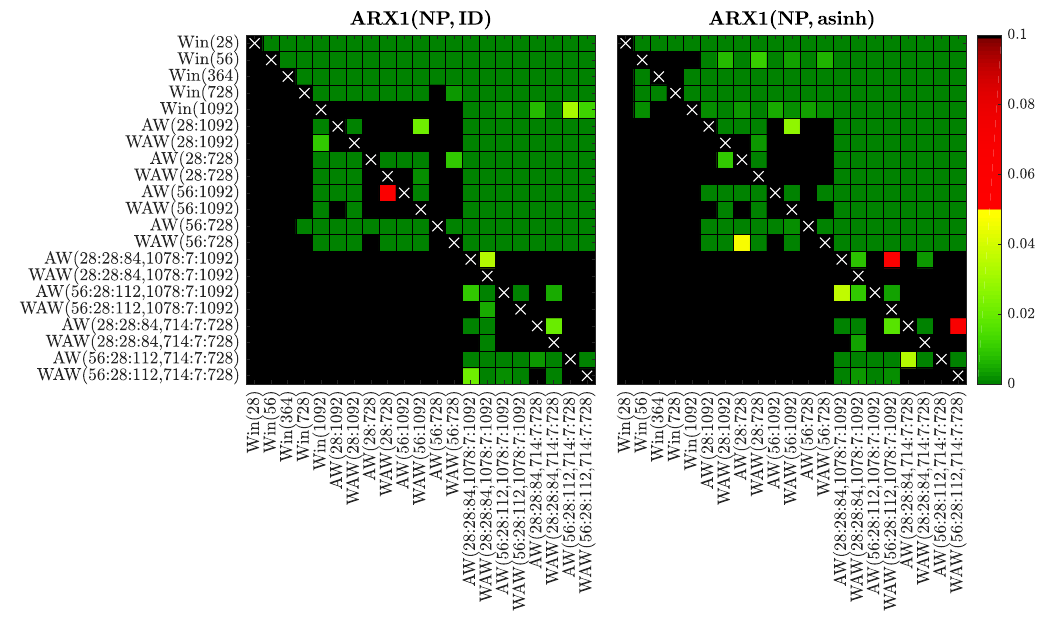
Figure 8. Results of the conditional predictive ability (CPA) test [32] for selected window sets and the ARX1 model fitted to raw ( left ) or asinh -transformed ( right ) Nord Pool data. We use a heat map to indicate the range of the p -values – the closer they are to zero ( → dark green) the more significant is the difference between the forecasts of a set on the X -axis (better) and the forecasts of a set on the Y -axis (worse).